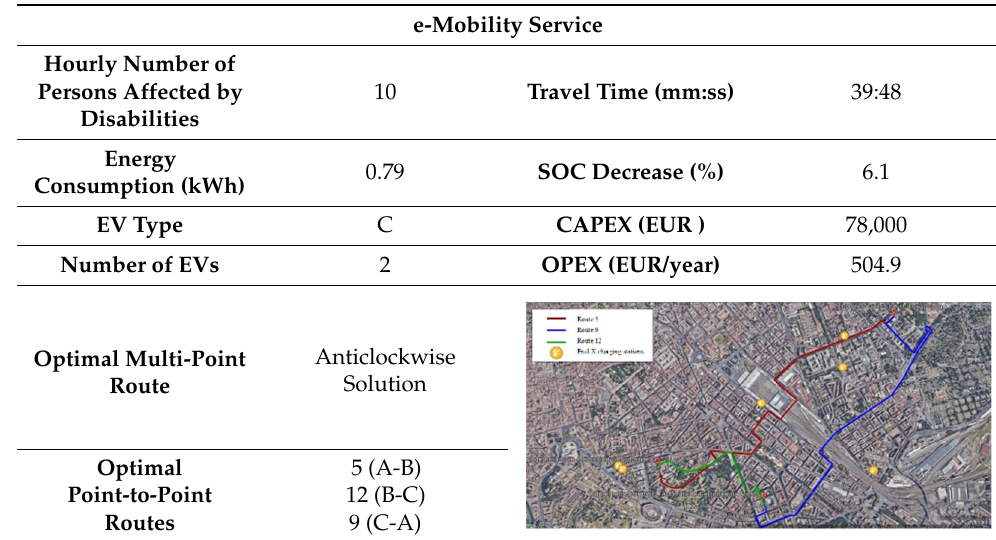
Figure 15. Google Earth map of the multi-point route selected by the software: route 5 in red; route 12 in green; route 9 in blue; charging stations installed near the route in yellow.